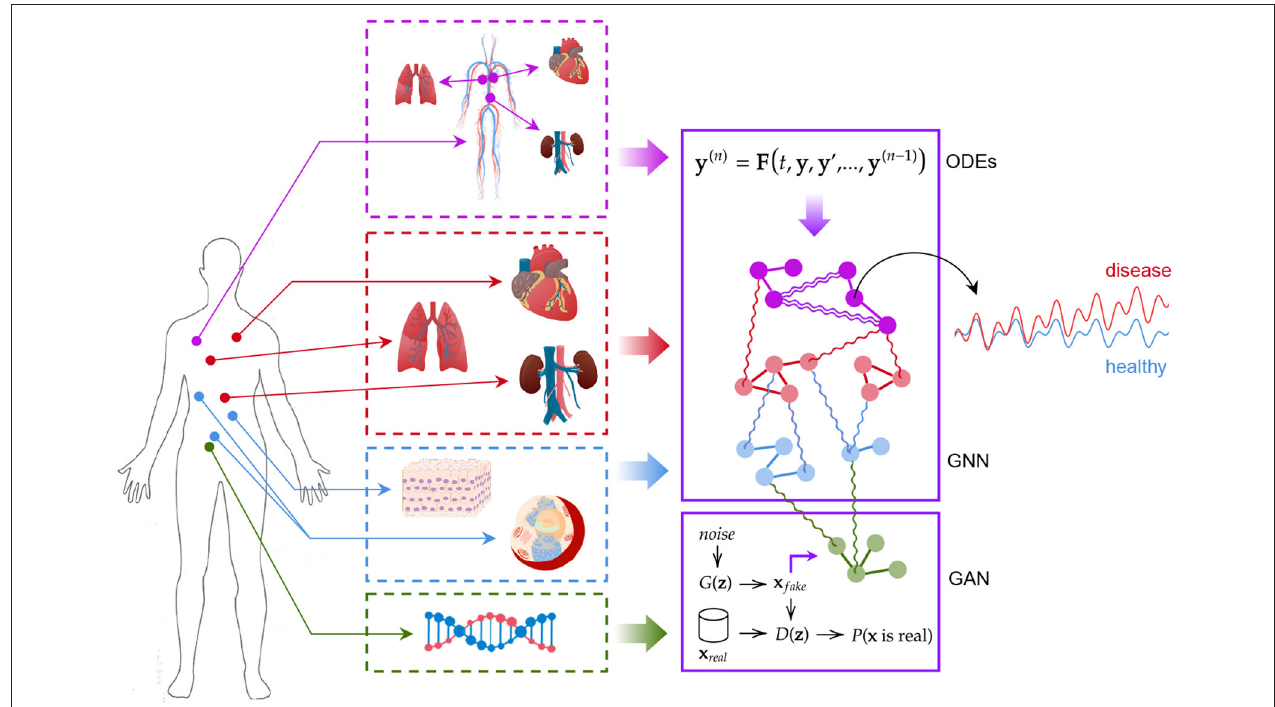
FIGURE 2 | The digital twin model. Ordinary differential equations, graph neural networks, and generative adversarial networks are used synergically to model patient’s